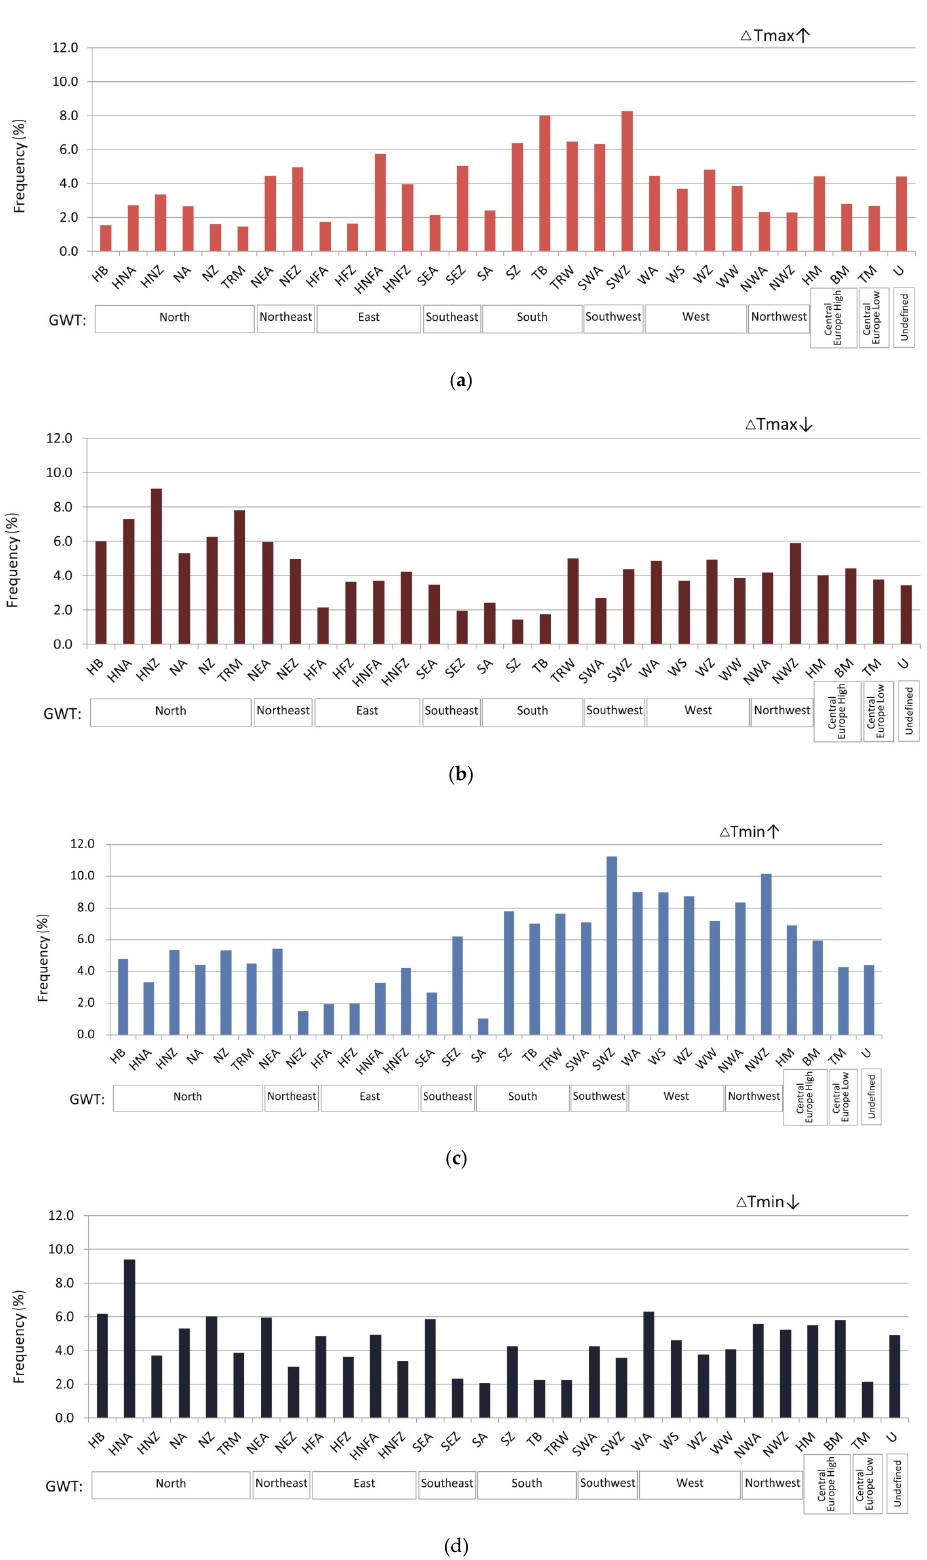
Figure 12 . Probability of the occurrence of large interdiurnal of extreme air temperature changes in the particular GWL circulation types in the years 1966–2015: ( a ) Δ Tmax ↑ ; ( b ) Δ Tmax ↓ ; ( c ) Δ Tmin ↑ ; ( d ) Δ Tmin ↓ . Explanations of the GWL types: see Table 1.